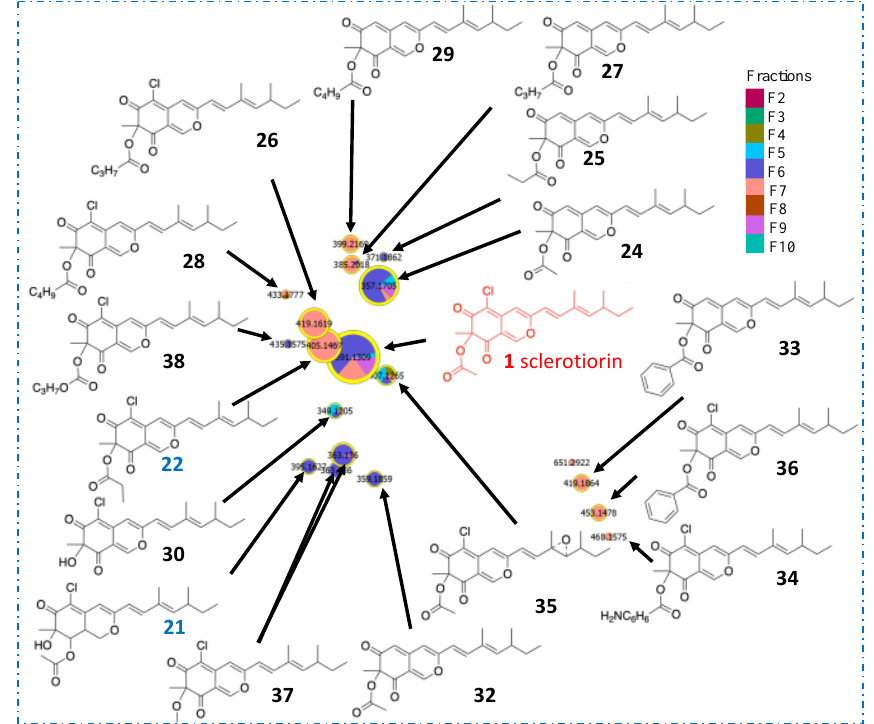
Figure 3. Annotation cluster A included sclerotiorin ( 1 ) with hypothetical structures proposed from molecular network data. In red and blue are molecules identified directly in MN (isochromophilone IV ( 21 ) and sclerketide B isomer ( 22 )), in black are molecules annotated with MS/MS.